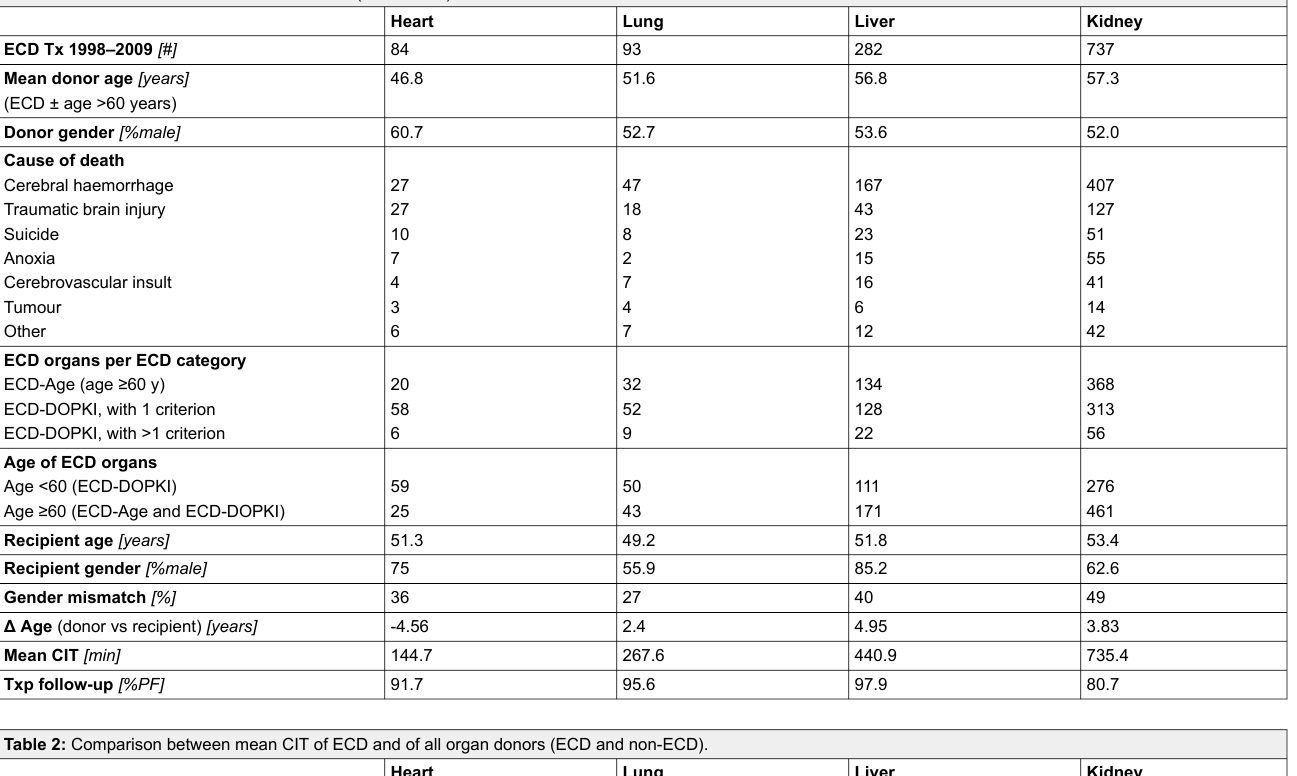
Table 1: Characteristics of ECD in Switzerland (1998–2009).